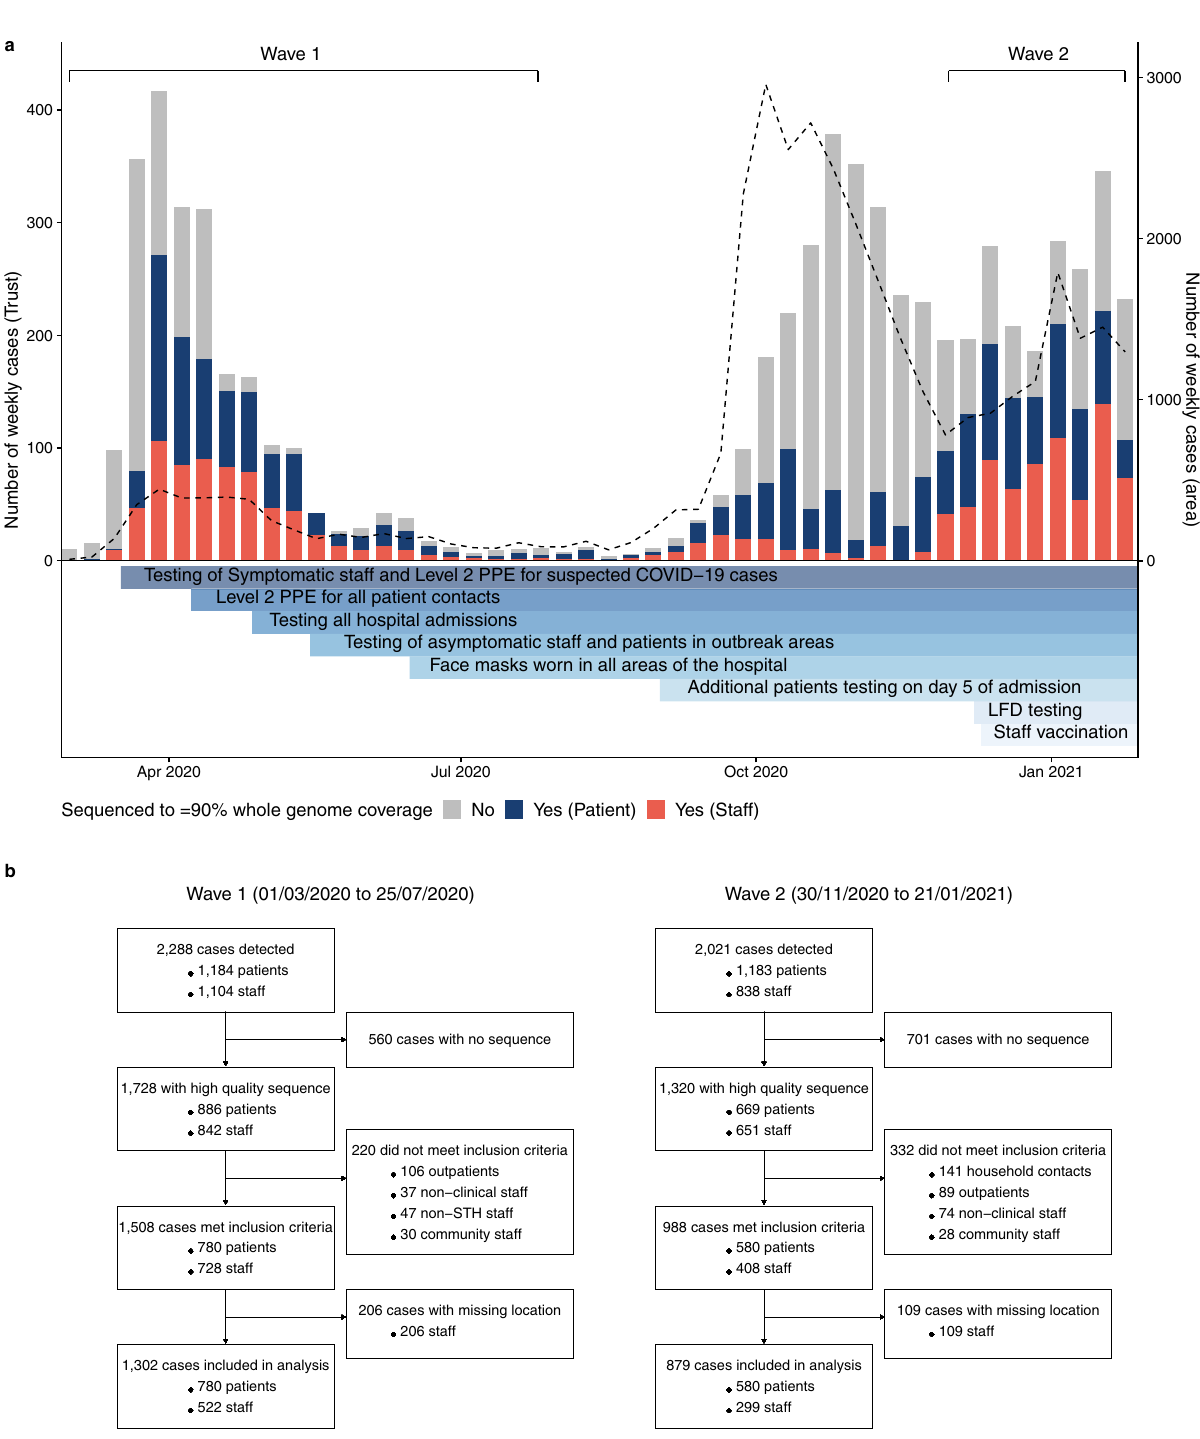
Fig. 1 SARS-CoV-2 positive staff and healthcare worker samples included in the study. a SARS-CoV-2 positive cases in patients and staff at Shef fi eld Teaching Hospitals NHS Foundation Trust (STH) over time (left Y axis), and implementation of testing, prevention and control interventions. All SARS- CoV-2 nucleic acid ampli fi cation tests from STH patients and staff found to be positive in the hospital (pillar 1) diagnostic laboratory are shown in grey bars. Sequences with genome coverage of 90% or higher for samples from healthcare workers (red) and patients (blue) are shown. These relate to samples with high-quality sequences (1728 in Wave 1 and 1320 in Wave 2) shown in Fig. 1b. The dashed line shows weekly case numbers in the Shef fi eld area (right Y axis); data taken from ref. 41 . Level 2 positive protective equipment (PPE) — aprons, gloves, eye protection and fl uid resistant surgical face mask. LFD testing — Lateral fl ow device testing for staff two times per week. Grey bars represent SARS-CoV-2 cases tested (staff and patients) testing positive in the STH pillar 1 diagnostic laboratory with no high-quality sequence available. Wave 1 and Wave 2 denote periods and samples included in the study. b Details of SARS-CoV-2 positive cases from patients and healthcare workers sequenced and included in the study.